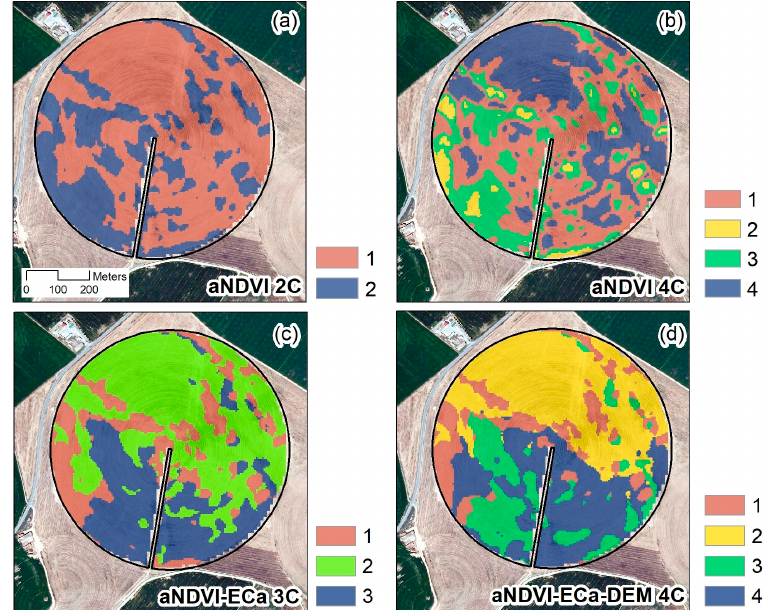
Figure 6. Classified maps as result of the fuzzy c -means algorithm implemented in the Management Zone Analyst (MZA) software based on: ( a ) the aNDVI with two and ( b ) four classes, ( c ) the combination of aNDVI-ECa with three classes, and ( d ) the combination of aNDVI-ECa-DEM with four classes. Numbers in the legends indicate the name of the classes.